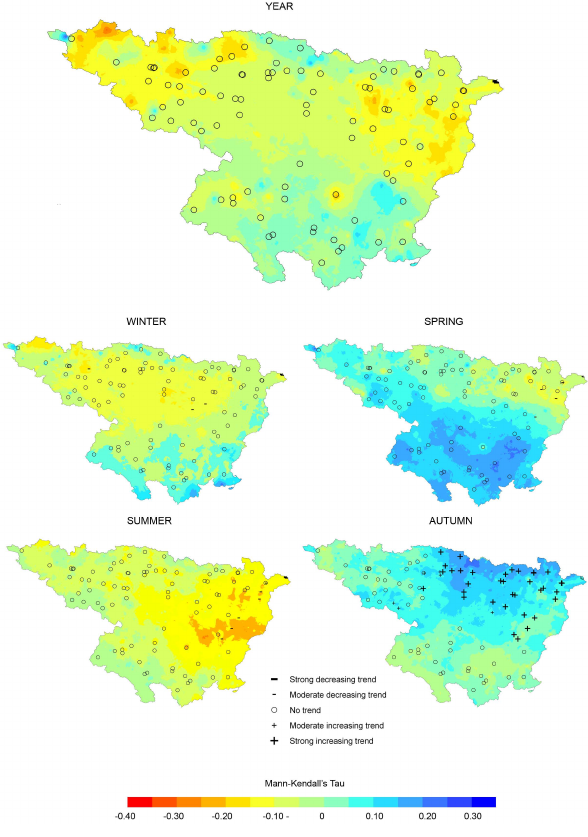
Fig. 2. Trend of annual and seasonal precipitation for the Ebro basin during the studied period (1950–2006). The color scale shows the Mann-Kendall tau coefficients for each 1km 2 cell. The symbols show the sign of the trend for total precipitation in the area drained at each of the 88 gauging stations.